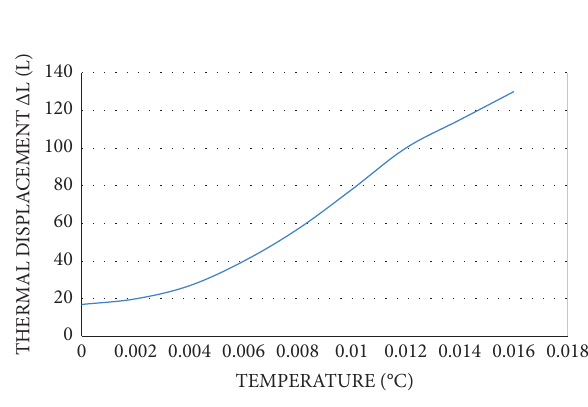
Figure 2: Comparison between thermal displacement and temperature.